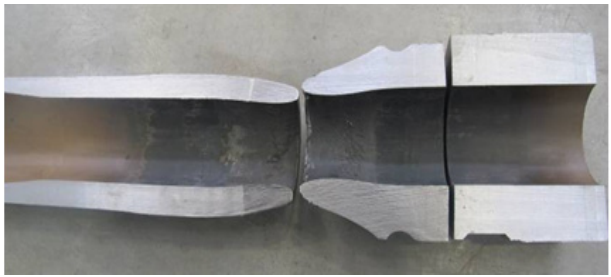
Figure 2. Damage morphology of coating on inner wall of failed drill pipe.